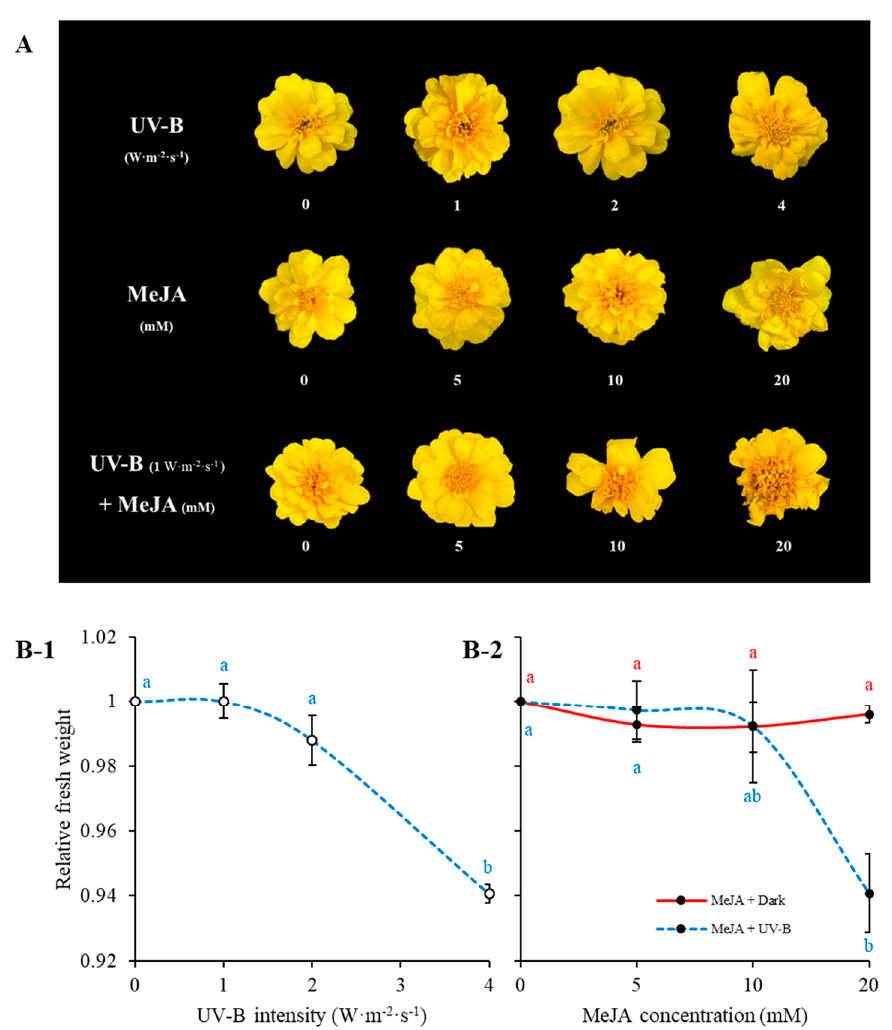
Figure 1. Morphological appearance of marigold flowers treated with different UV-B intensities and MeJA concentrations for 10 days ( A ). Each row in ( A ) represents treatment with UV-B alone (without MeJA), MeJA alone (without UV-B), and treatment by MeJA concentration under UV-B 1 W · m − 2 · s − 1 . Relative fresh weight of marigold flowers depending on UV-B intensities ( B-1 ) and MeJA concentrations (with or without UV-B 1 W ∙ m − 2 ∙ s − 1 ) ( B-2 ) treatment for 10 h within a day. The relative weight was expressed as the mean ± SE value of the weight of triplicate samples. Alphabetically small and different letters on graphs indicates significant differences in Tukey’s studentized test at p < 0.05.